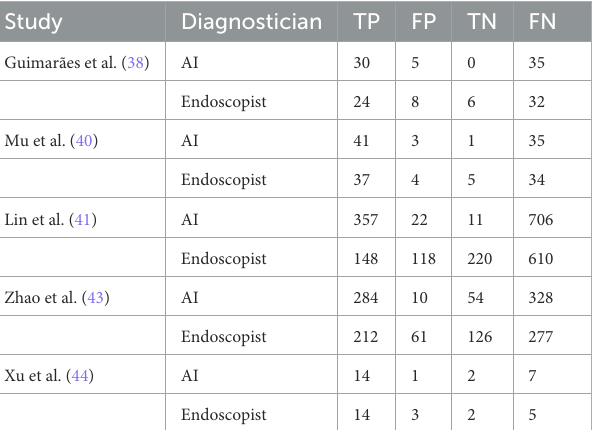
TABLE 3 AI vs. endoscopist related